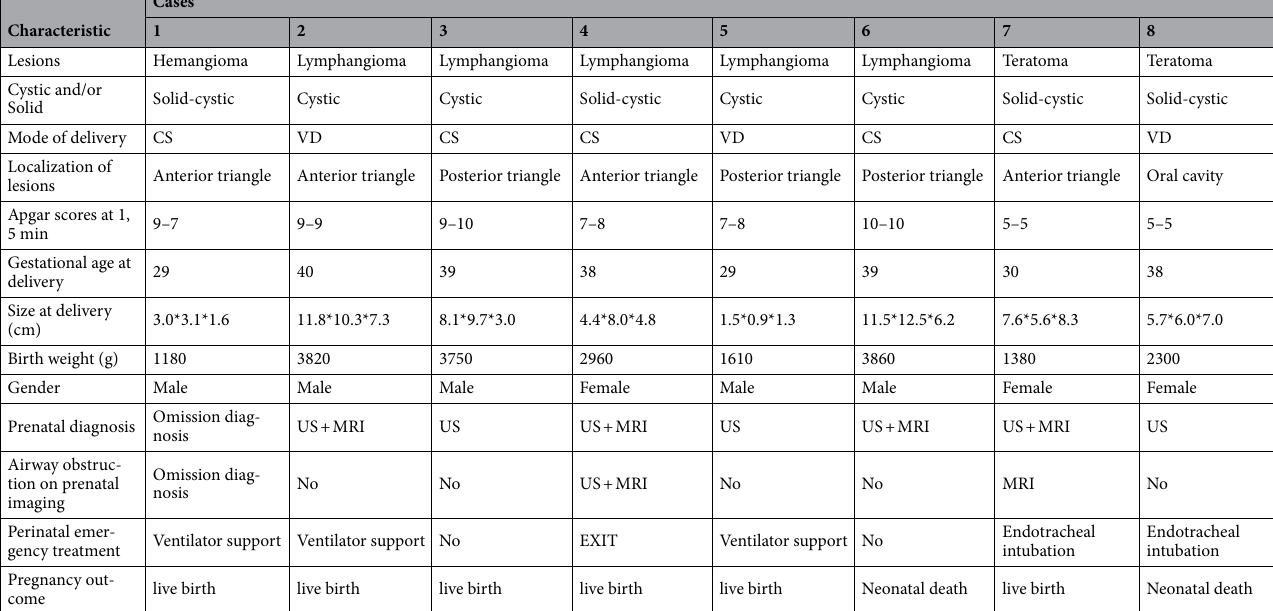
Table 3. Clinical analysis of 8 cases of fetuses with poor perinatal prognosis. CS cesarean section, VD vaginal delivery, EXIT ex-utero intrapartum